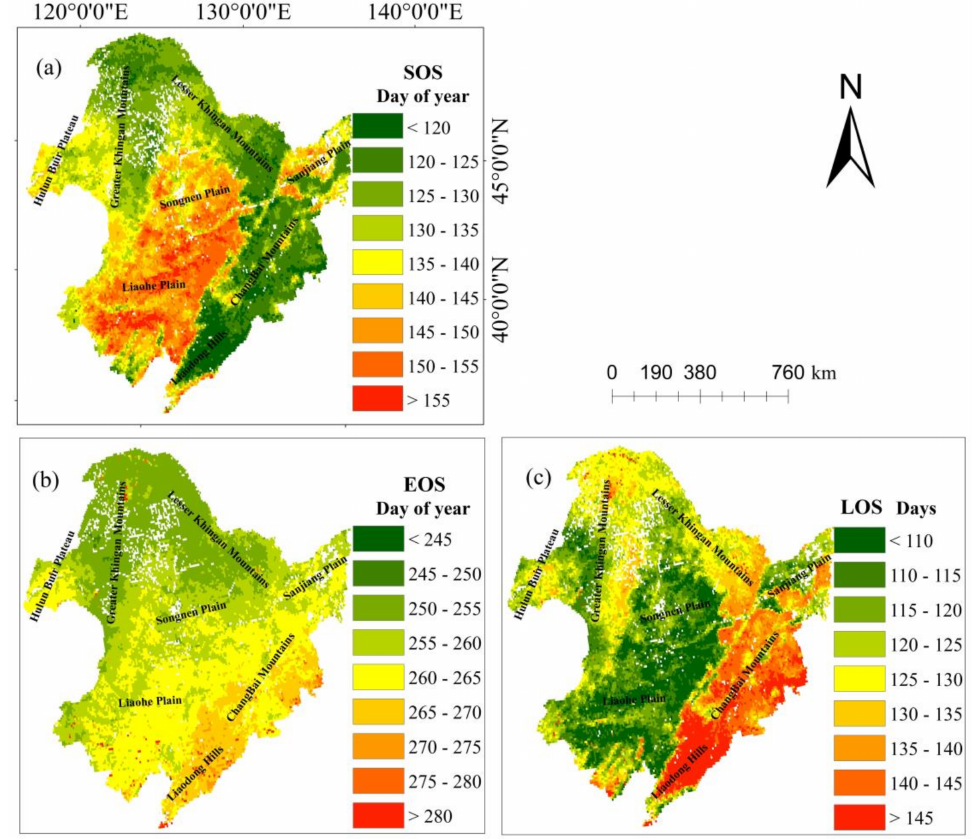
Figure 3. Spatial distribution pattern for ( a ) average SOS, ( b ) average EOS, and ( c ) average LOS of northeast China during